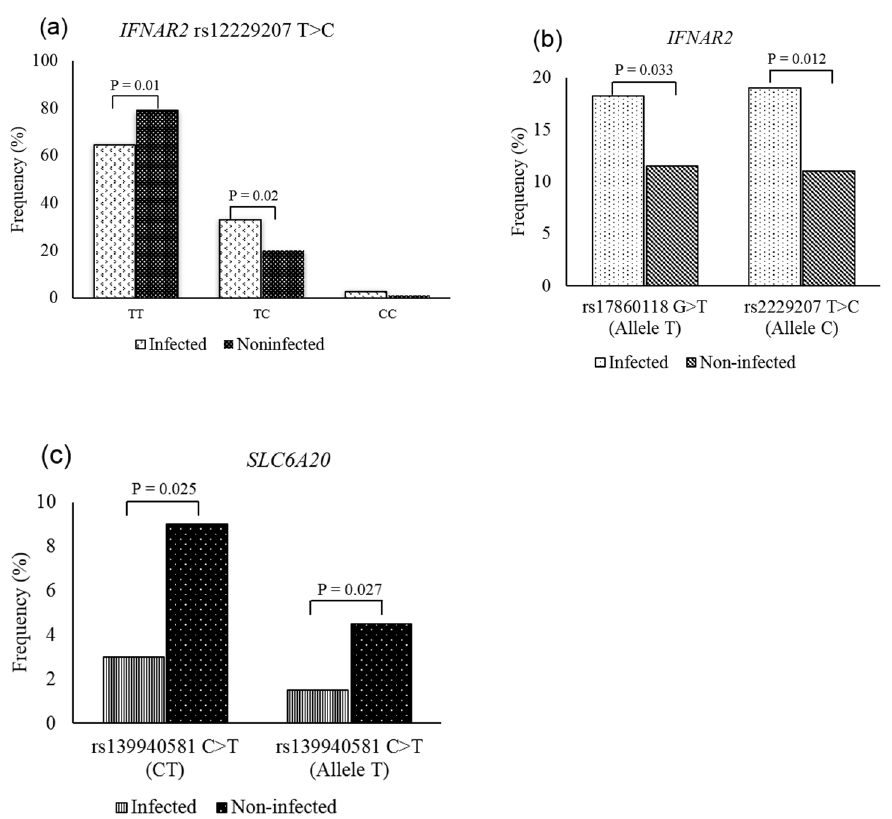
Figure 2. Frequency distribution of IFNAR2 and SLC6A20 genotypes and alleles studied cohort. ( a ) For IFNAR2 rs12229207, COVID-19 patients carrying TT genotype showed significantly higher frequencies than the controls, while the frequency of the CT genotype was significantly higher in the controls compared with the patient’s group; ( b ) for both IFNAR2 rs12229207 and rs17860118, the mutant alleles were significantly higher in the infected individuals compared to the controls; ( c ) for SLC6A20 rs139940581, there was a significantly higher frequency of infected individuals carrying CT genotype and allele T compared with those observed in the controls.